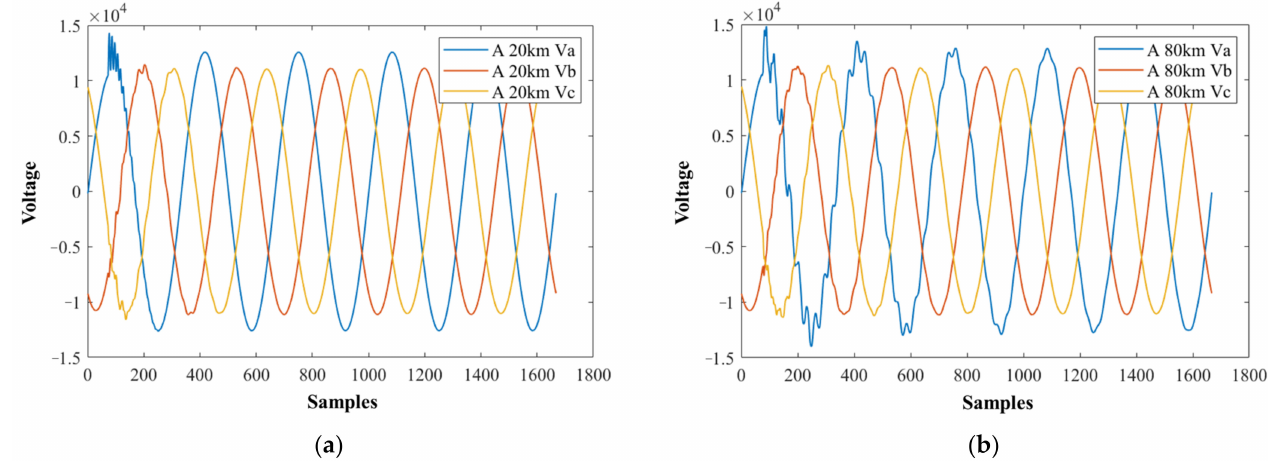
Figure 8. Fault voltages by distance: ( a ) 20 km and ( b ) 80 km.